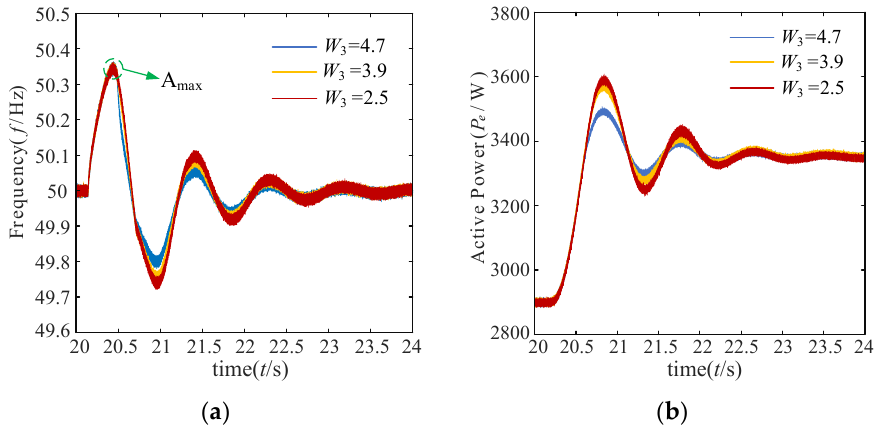
Figure 14. The influence of control parameter W 3 variations on the system: ( a ) System frequency waveforms; ( b ) Output waveforms active power.